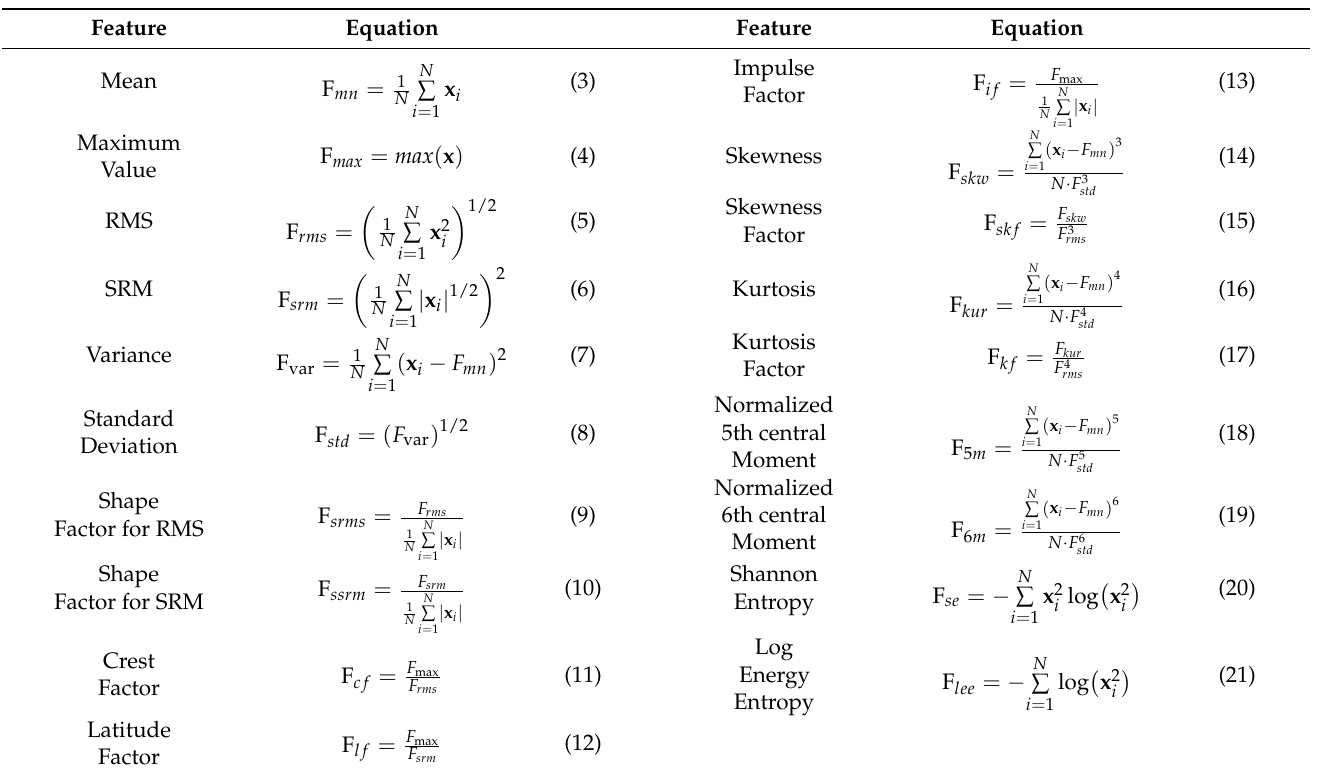
Table 1. Statistical time